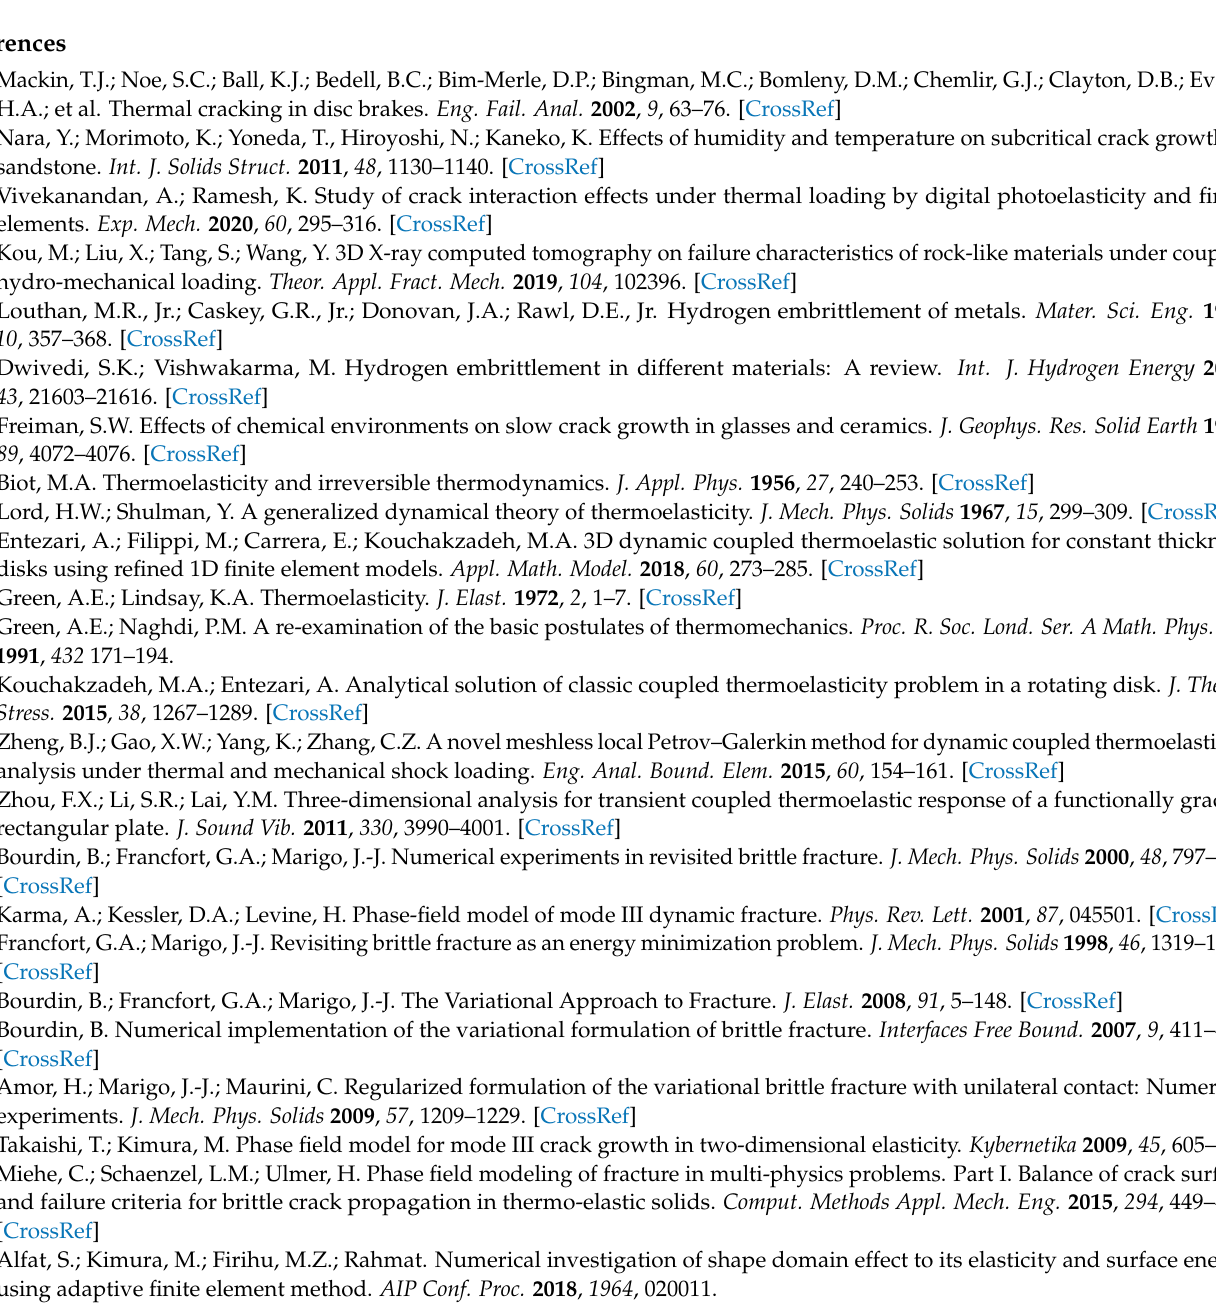
Figure A1. Profile of displacement [ u 1 , u 2 ] ( left ), div u ( center ), and ∂ crack under Mode